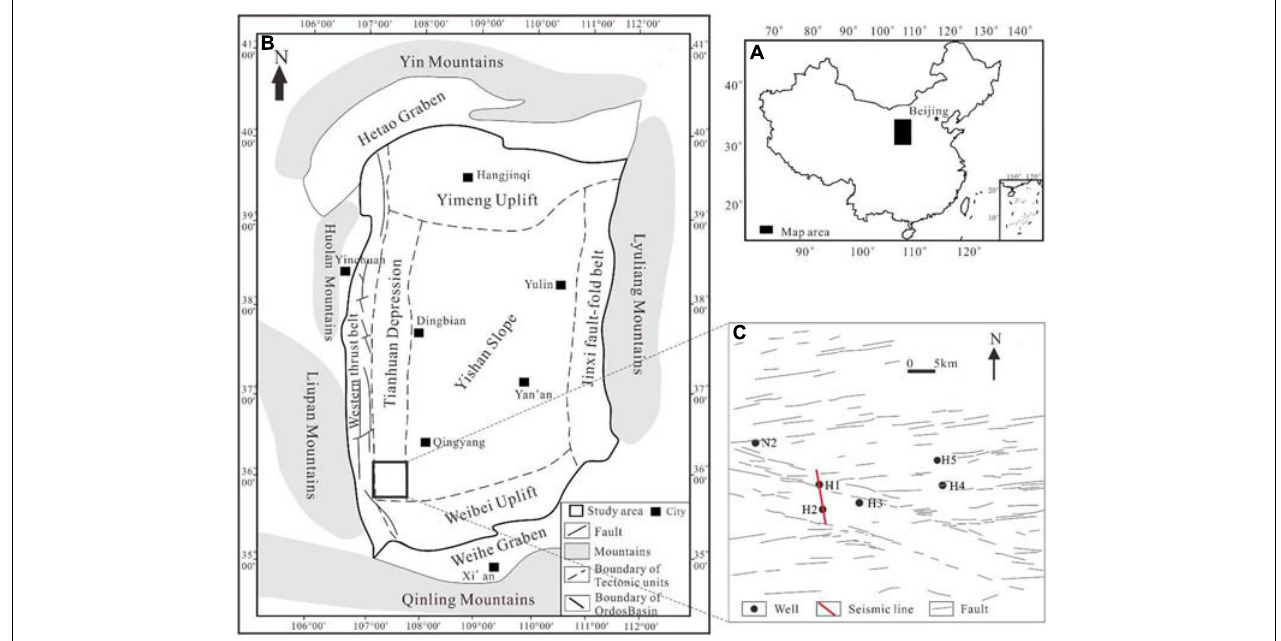
FIGURE 1 | Location map of the Ordos Basin, study area, wells, and fault systems (modified from Zeng and Li, 2009; Lyu et al., 2016; Lyu et al., 2017a, 2019). (A) Location of the Ordos Basin. (B) Location of the study area and tectonic units of the Ordos Basin. (C) Location of wells, seismic line, and fault systems in the study area.